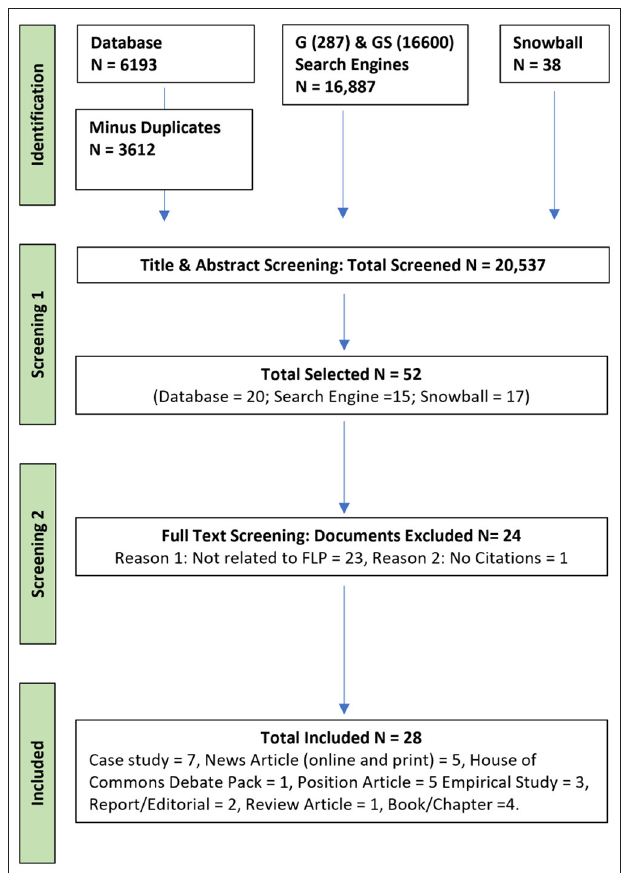
FIGURE 1 | Preferred Reporting Items for Systematic Reviews and Meta-Analyses (PRISMA) flow diagram for scoping